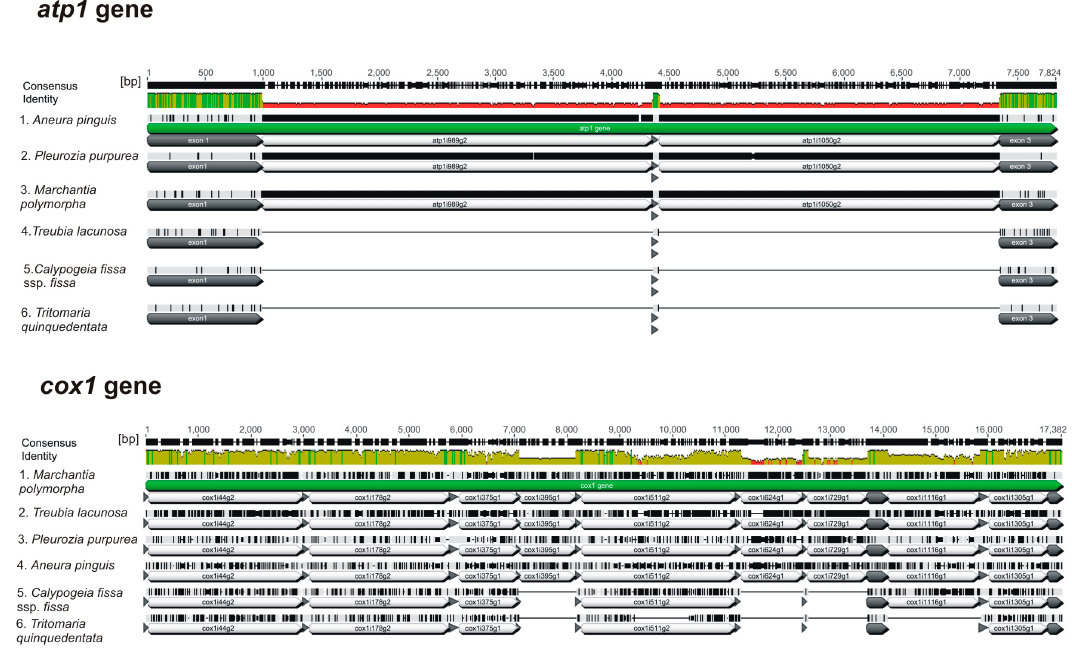
Figure 2. Comparison of the atp1 and cox1 gene structures of different liverwort species. Lost introns are marked with lines.